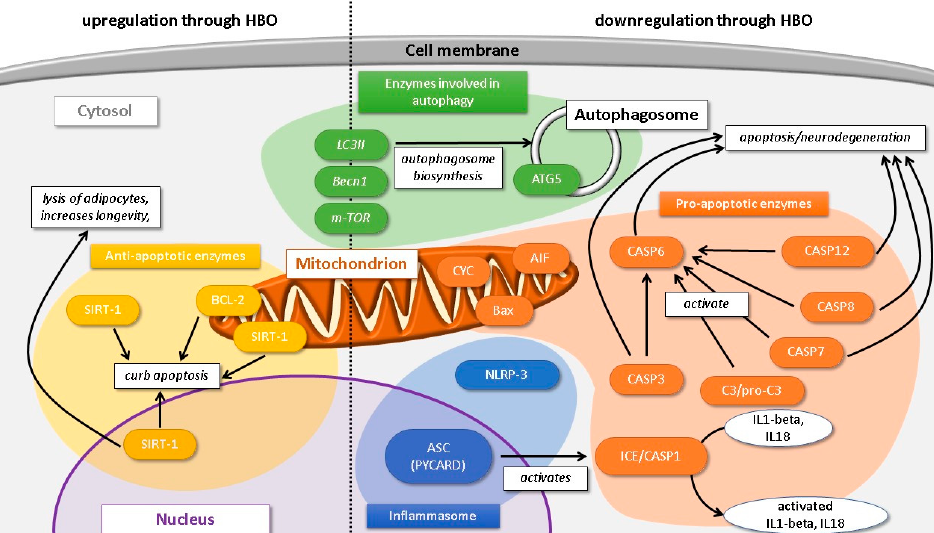
Figure 3. Current evidence suggests that hyperbaric oxygenation (HBO) exerts antiapoptotic effects via the downregulation of apoptotic enzymes: NLRP-3 interacts with components of damaged cells and, together with ASC, induces inflammation. Both form the inflammasome, engaging ICE/CASP1, which furthermore converts pro-inflammatory interleukins into an active form. C3/pro-C3 activates CASP6, CASP6/7/8/12 engage CASP3, and all mediate and effect apoptosis. CYC, Bax and AIF reside in the mitochondria and are pro-apoptotic. Conversely, the antiapoptotic mitochondrial enzymes SIRT1 (also present in nucleus and cytosol) and BCL-2 are upregulated by HBO which in turn enhance cell viability as they curb apoptosis. HBO exerts variable effects on proteins in the cytosol, LC3II, Becn1 and m-TOR, which are involved in autophagy processes; however, there is evidence that ATG5 protein residing in autophagosome membrane is downregulated by